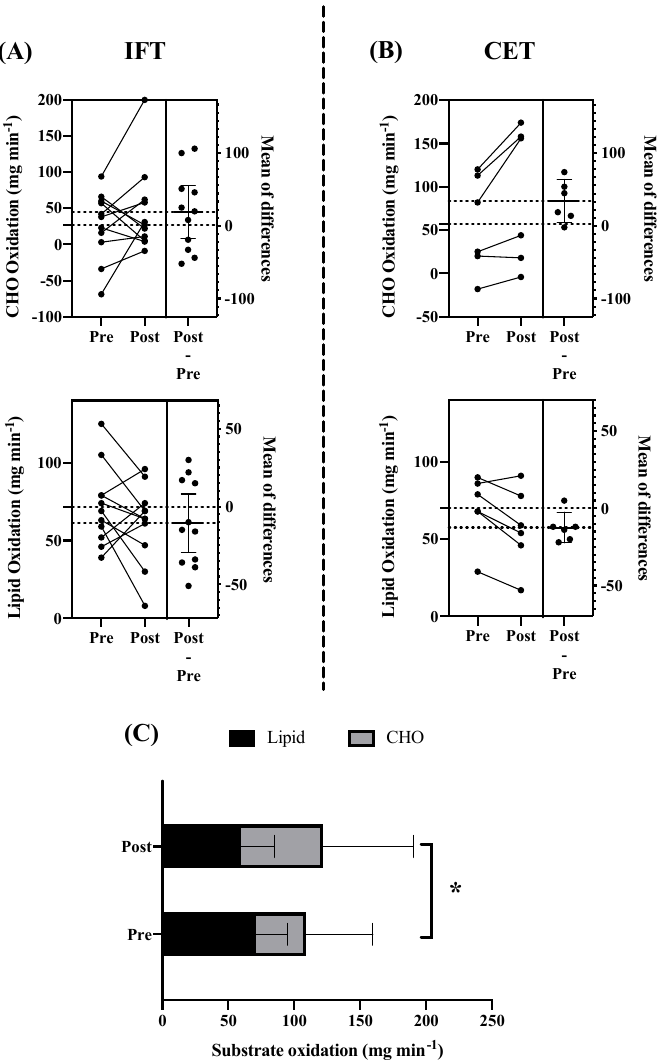
Figure 5. Resting Substrate Partitioning. Changes in rates of resting carbohydrate (CHO) and lipid oxidation over the intervention period. ( A ) Intermittent functional training (IFT), ( B ) constant-load ergometer training (CET), and ( C ) combined groups. Panels A and B display individual changes along with mean difference and 95% CI. Panel C displays pre to post changes in substrate partitioning across both groups, * p < 0.05.